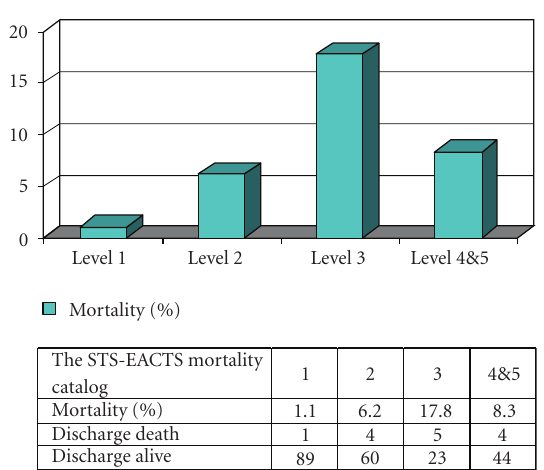
Figure 4: Mortality rate by STS-EACTS mortality categories in the present study ( n =